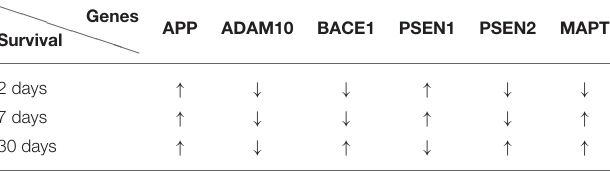
TABLE 2 | Changes in the expression of the Alzheimer’s disease-linked genes in the CA3 region of the hippocampus at various times after experimental ischemic brain